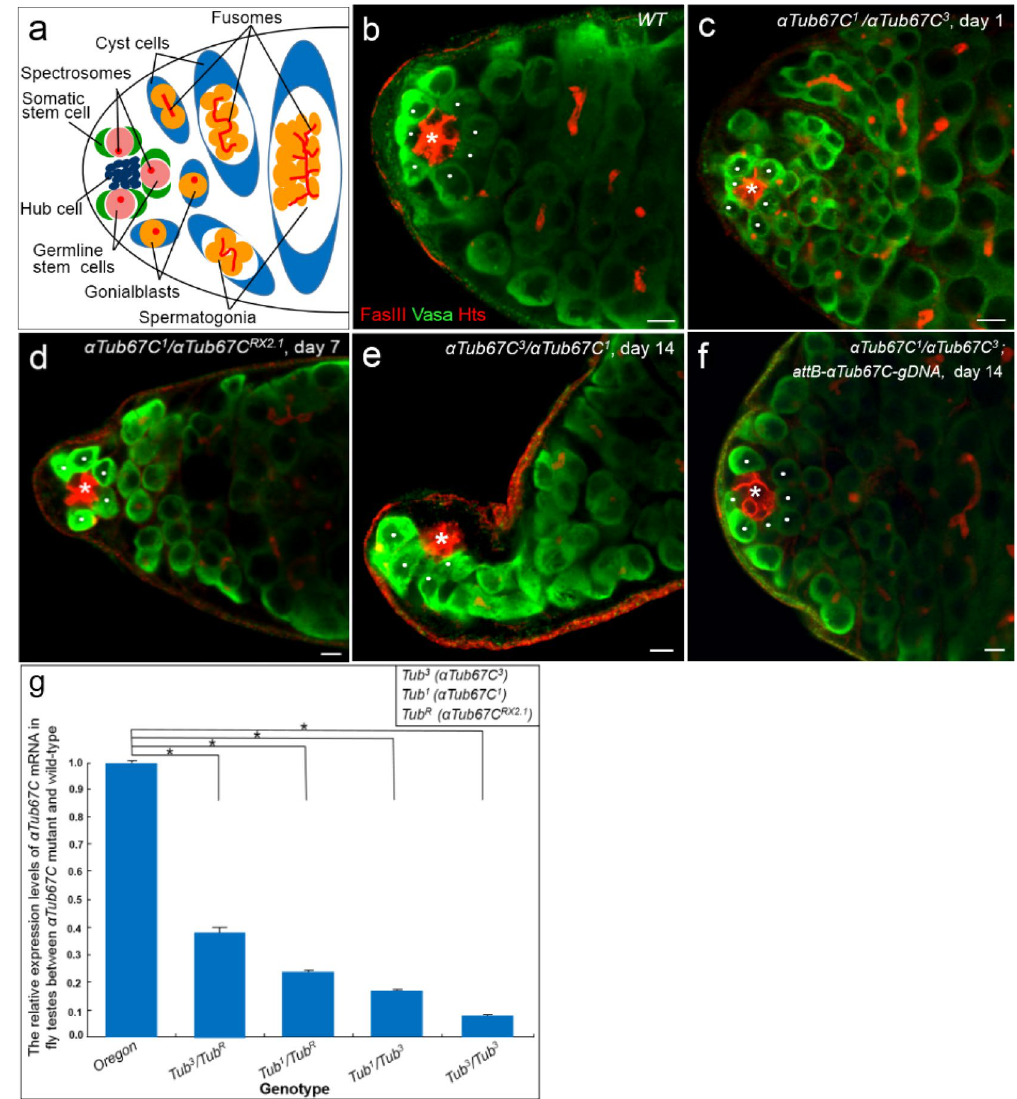
Figure 1. αTub67C is required for maintaining GSCs in Drosophila testis. (a) A schematic diagram of an adult testis. GSCs (pink), Hub cells (dark blue), Somatic stem cells (green), Gonialblasts (yellow), cyst cells (blue), and fusomes (red). ( b) Testis from the wild-type ( WT ) fly. (c–e) αTub67C mutant testes at different ages showed the GSC loss phenotypes. (f) The transgene P{ attB-αTub67C-gDNA } rescued the αTub67C mutant testis to normal. ( g) Quantitative PCR analyses of αTub67C mRNA levels in testes between wild-type and αTub67C mutants. Testes stained with anti-Fas III antibody to label the hubs (red, indicated by asterisks), anti-Hts antibody to label the fusomes (red), and anti-Vasa antibody to label germ cells (green) ( b – f ). GSCs were highlighted by white dots. Testes with 7 GSCs ( b and f ), 6 GSCs ( c ), 5 GSCs ( d ) and 4 GSCs ( e ) are shown. Oregon-R was used as the wild-type flies. Scale bars: 5 μm. * p <